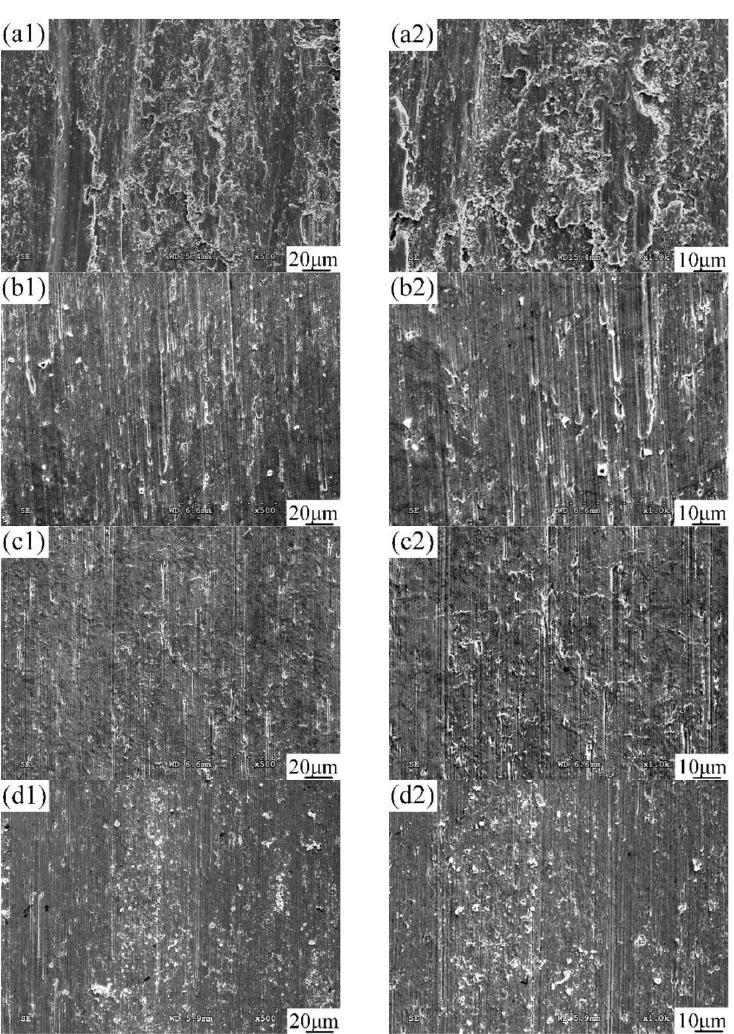
Figure 14. The SEM worn surface morphologies of the coatings. ( a1 , a2 ) Ti6Al4V. ( b1 , b2 ) The 25 wt.% Ni-MoS 2 coating. ( c1 , c2 ) The 35 wt.% Ni-MoS 2 coating. ( d1 , d2 ) The 45 wt.% Ni-MoS 2